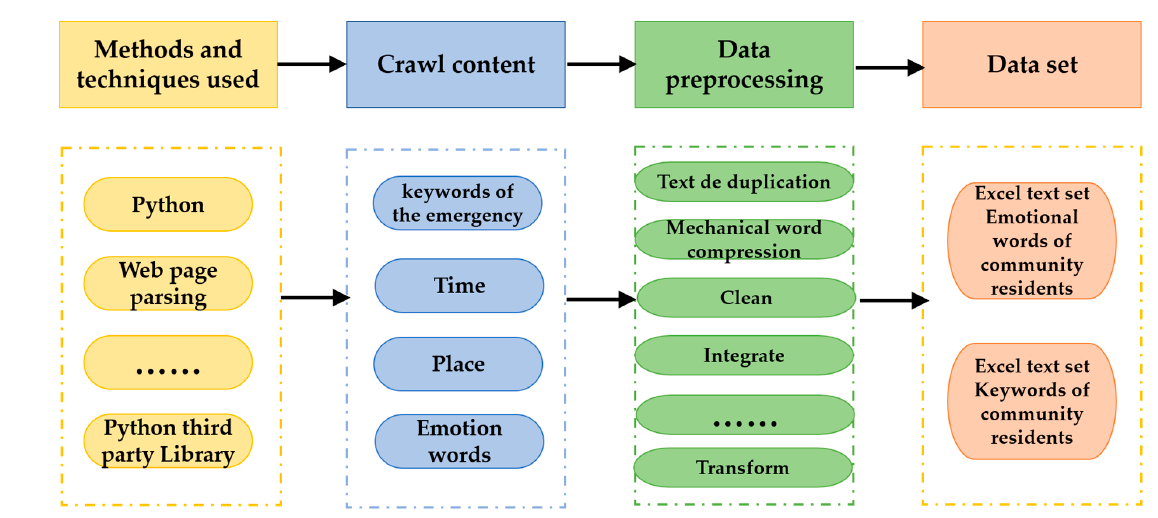
Figure 2. Network big data crawling and processing process.